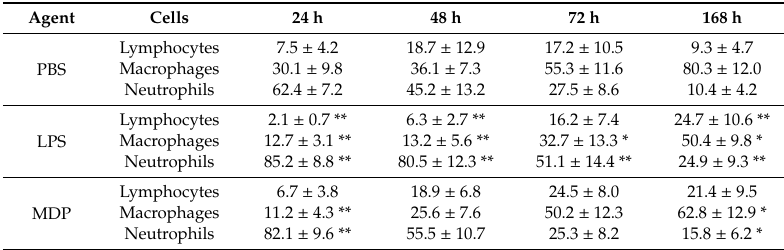
intramammary application of PBS, LPS, and